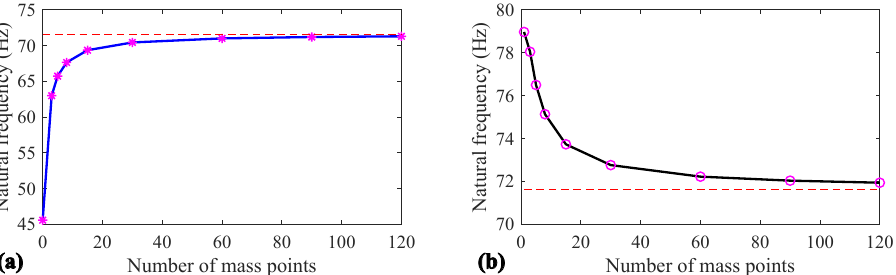
Figure 16. Convergence study of the lumped-mass model. ( a ) Natural frequency convergence of the main tether; ( b ) natural frequency convergence of the tethered system.